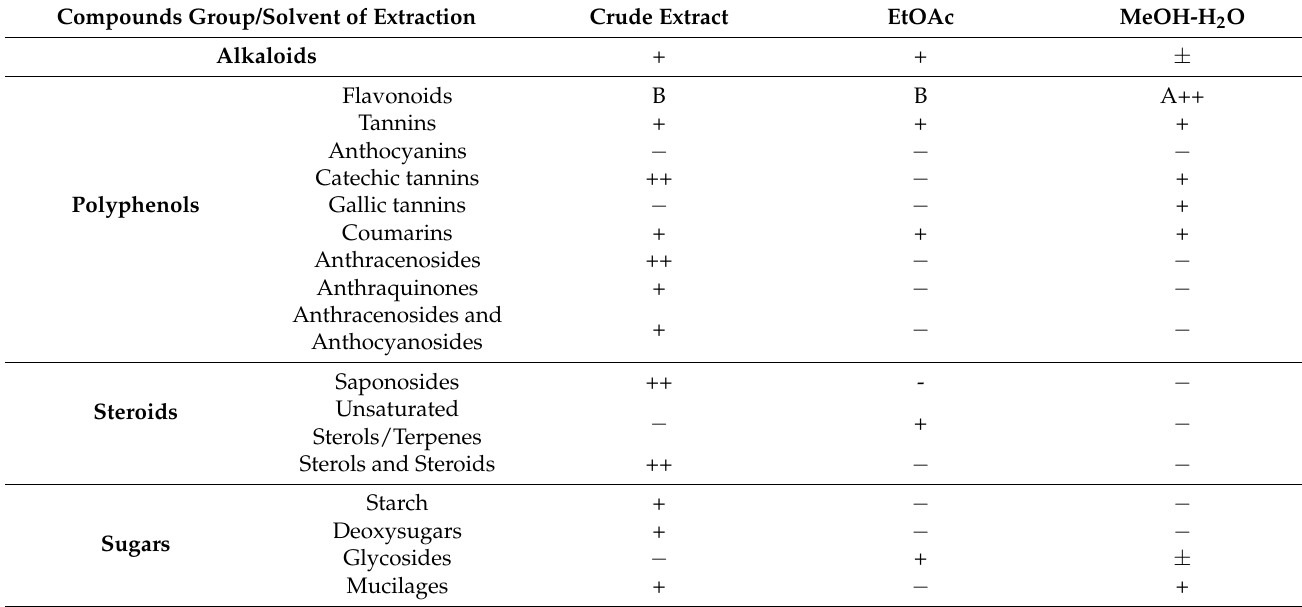
Table 2. Phytochemical screening of C. humilis samples.